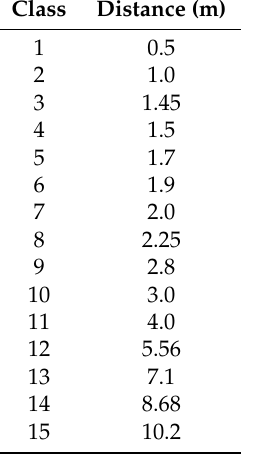
Table 5. Class labels for each source–microphone distance in the public dataset.